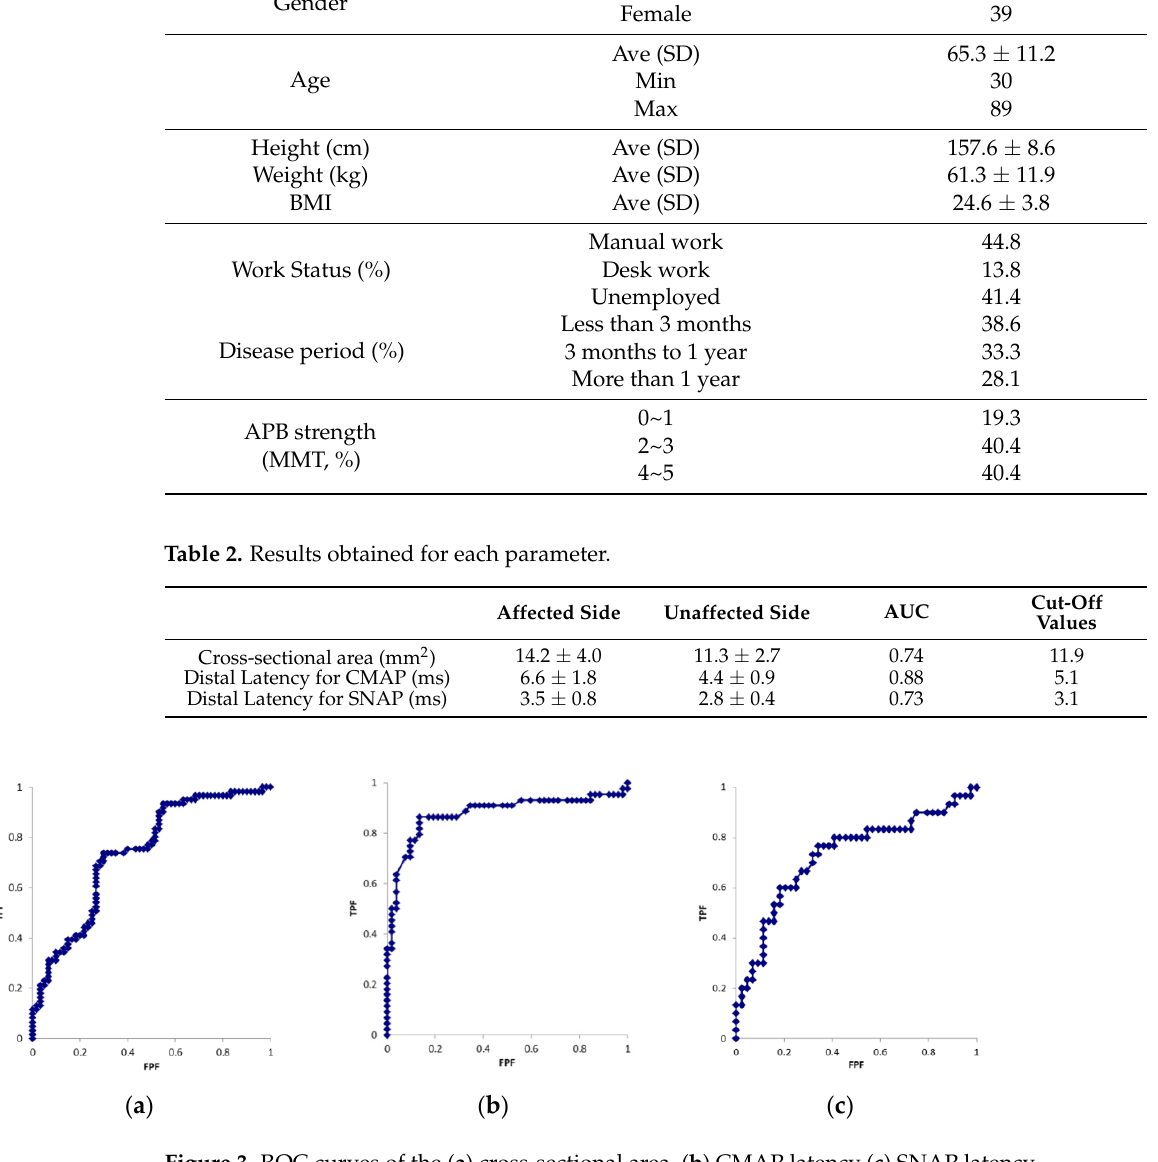
Figure 3. ROC curves of the ( a ) cross-sectional area, ( b ) CMAP latency ( c ) SNAP